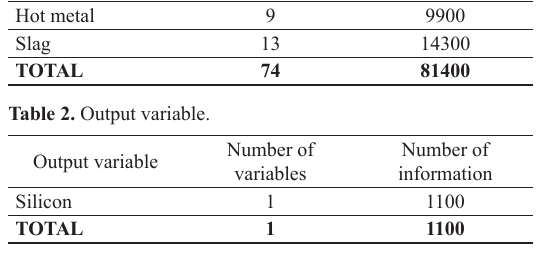
Table 3. Operacional